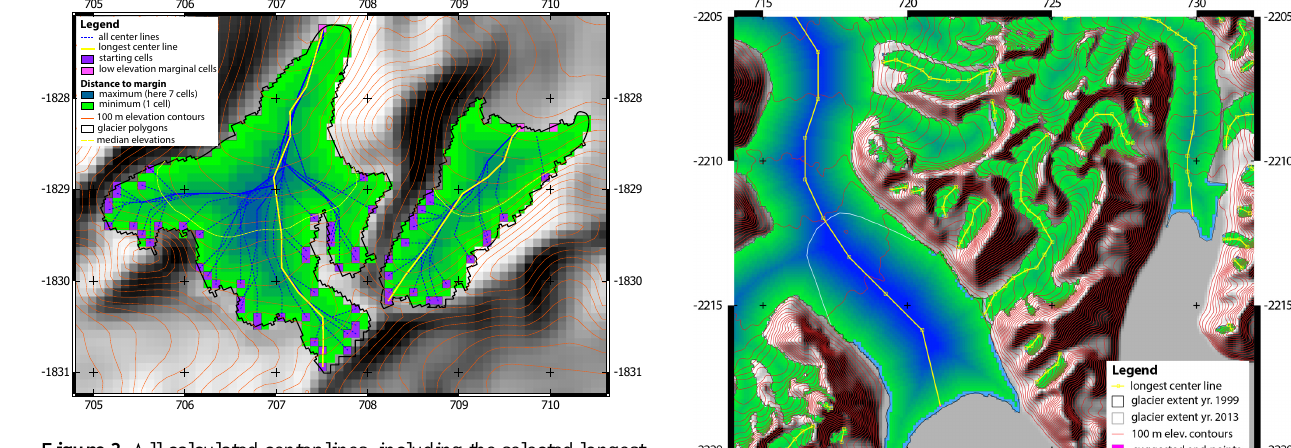
Figure 3. All calculated center lines, including the selected longest center lines calculated for two small mountain glaciers of East Greenland. Coordinates as in Fig. 2.